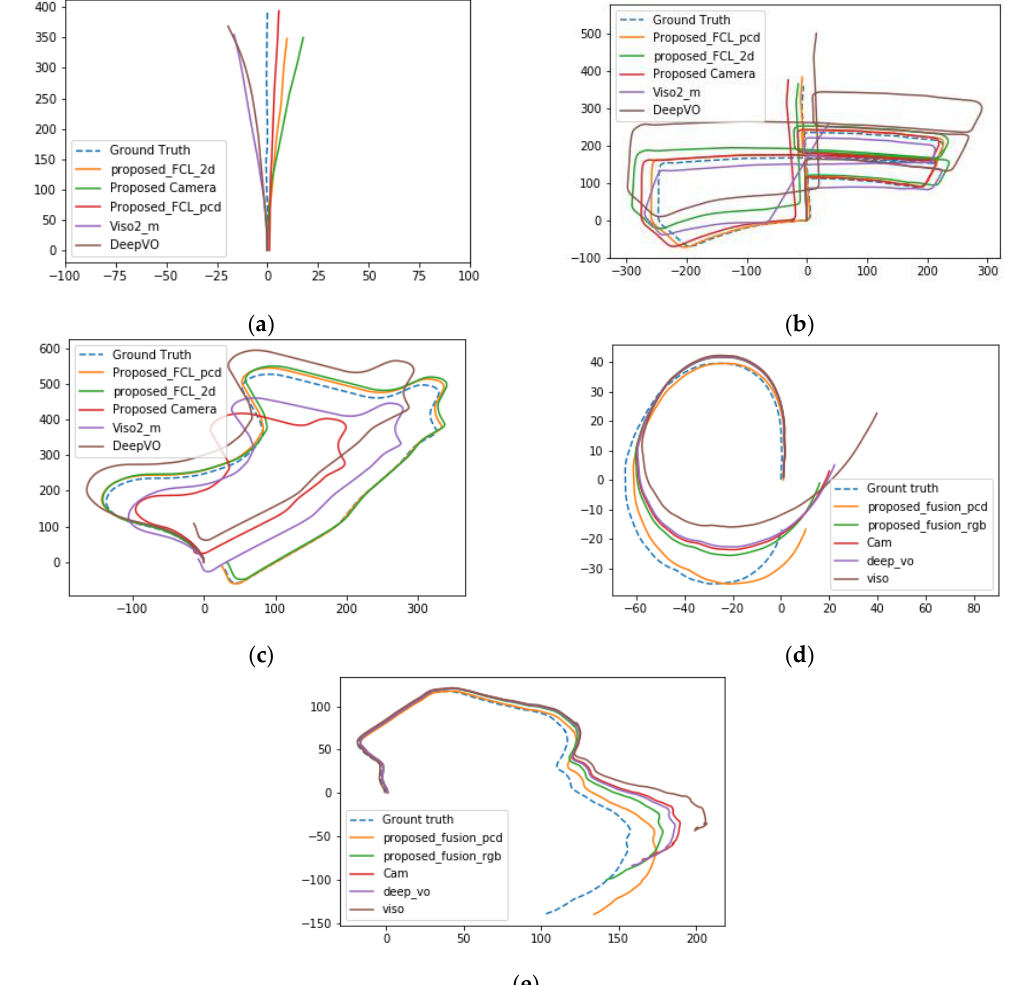
Figure 8. Results of the proposed algorithm’s trajectory (measured in meters) on the testing sequence. ( a – c ) Results with KITTI dataset sequence 04, 05 and 09, respectively; ( d , e ) results with sequence 01 and 02 of LboroAV2 dataset.